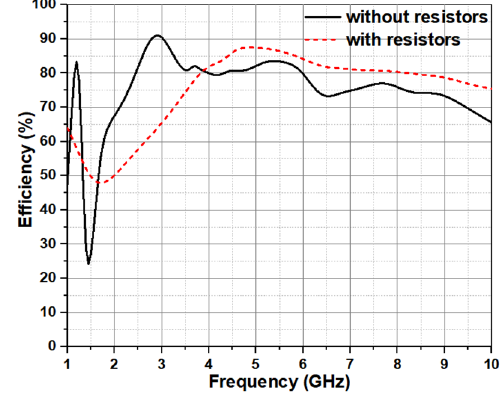
Figure 7. Effect of the resistors on radiation efficiency.